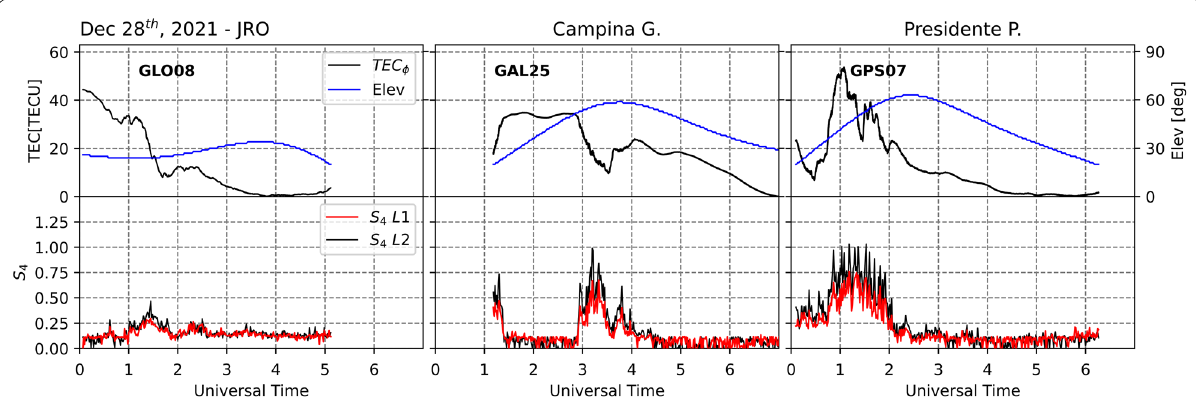
Fig. 11 Examples of TEC depletions (top) and amplitude scintillation at L1 and L2 signals (bottom) as measured by ScintPi 3.0 monitors located at JRO (left panels), CG (middle panels) and PPR (right panels) on December 28,